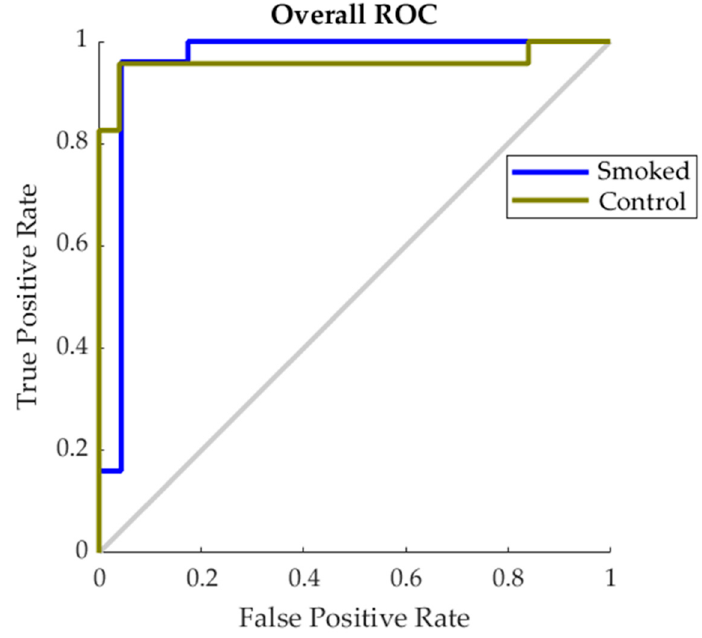
Figure 6. Receiver Operating Characteristic (ROC) showing the false positive rate ( x -axis) and true positive ( y -axis) for control and smoked treatments for the best performing classification model found in Table 3.